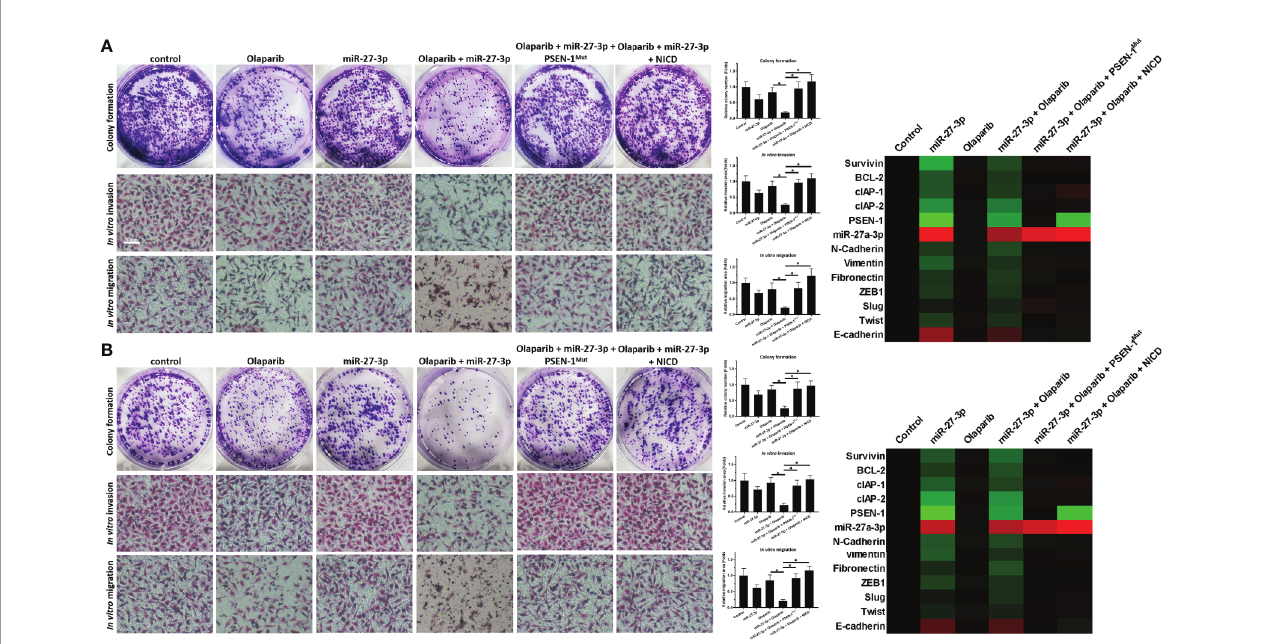
FIGURE 2 | miR-27-3p suppresses the in vitro survival or invasion/migration of TNBC cells by targeting the 3 ’ UTR of PSEN-1. (A, B) HCC1937 (A) or MDA-MB-436 (B) TNBC cells were transfected with plasmids or treated with 0.5 m mol/L of olaparib and harvested for colony-formation and Transwell assays. The results are presented as images and quantitative analysis. (A, B) The expression of the genes downstream of the Notch pathway in TNBC cells is presented as a heat map. *P <